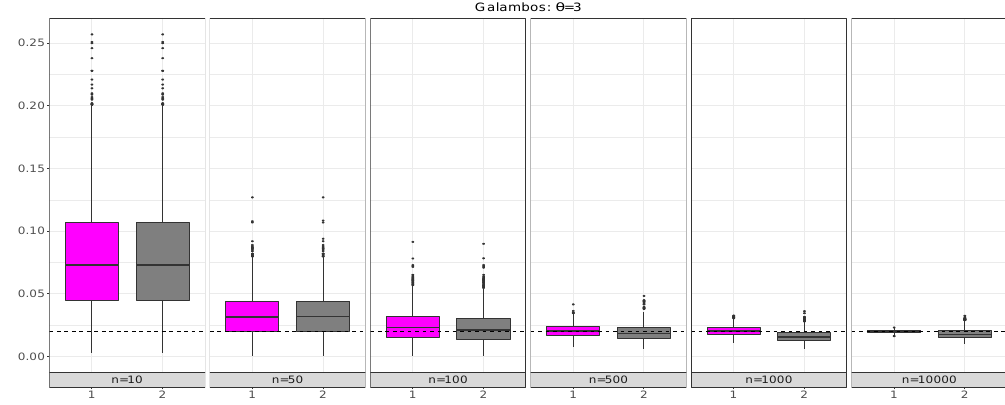
Figure 4: Boxplot summarizing the 1000 obtained estimates (pink: estimator based on ˆ A * n , gray: estimator based on checker- board approximations) for CoES = ( Y | X ) at levels α = 0.05 and γ = 0.05 α , γ , C A 3